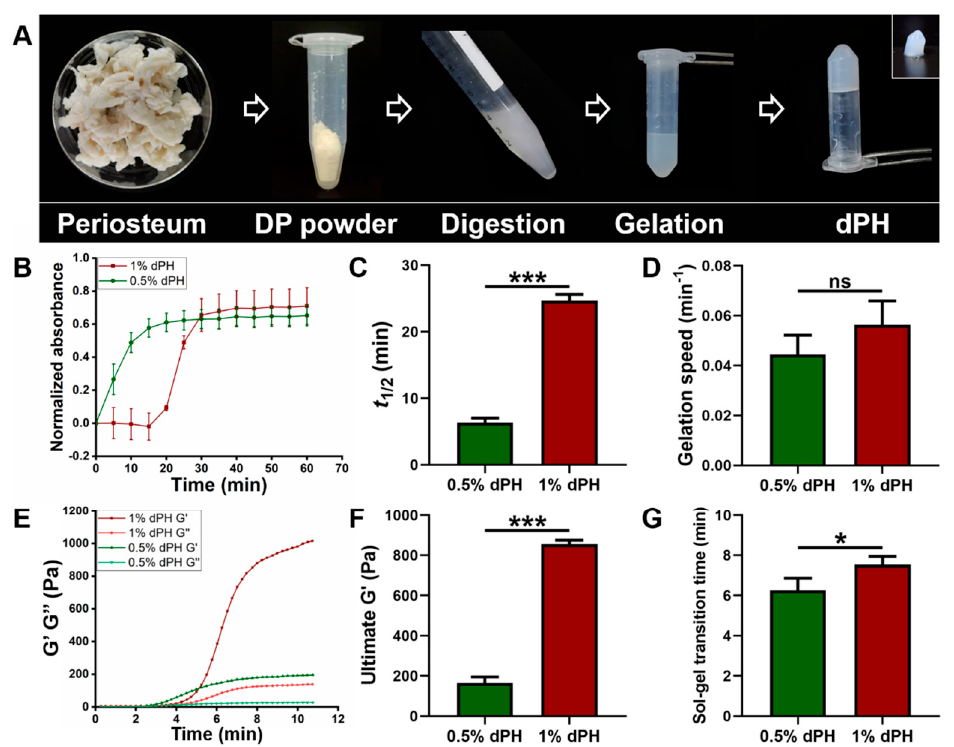
Figure 2. The fabrication process of dPH, its turbidimetric gelation kinetics, and rheological property. ( A ) Fabrication process of dPH. ( B ) Representative normalized absorbance curve of 0.5% and 1% dPH. ( C ) Time to reach 50% complete gelation of 0.5% and 1% dPH. ( D ) Gelation speed of 0.5% and 1% dPH. ( E ) Representative rheological property curve of dPH. G (cid:48) represents the storage modulus, and G” refers to the loss modulus. ( F ) Ultimate storage modulus of 0.5% and 1% dPH. ( G ) Sol-gel transition time of 0.5% and 1% dPH. ns, no significant difference, * p < 0.05, *** p <